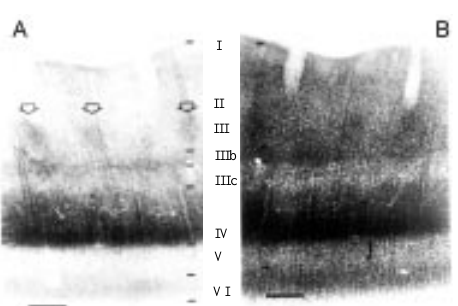
Figure 1 - Parasagittal section reacted for NADPH-d (A) and counterstained with Nissl (B) to visualize the corti- cal layers. Layer numbers according to Hässler’s (22) nomenclature modified by Lachica et al. (4). Open ar- rows point to blobs. Scale bar 200 = µm.